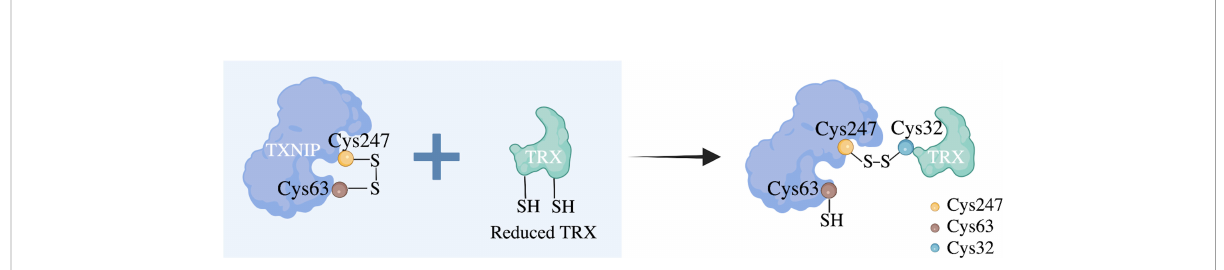
FIGURE 3 Proposed molecular mechanism of the negative regulation of TRX by TXNIP. The cellular redox state-dependent disul fi de bond switching mechanism regulates the inhibition of thioredoxin (TRX) by thioredoxin-interacting protein (TXNIP). TXNIP contains an intramolecular disul fi de band between cysteine residue (Cys) 63 and Cys247 that can interact effectively with TRX. Under normoxic conditions, TXNIP forms stable TRX- mixed disul fi de bonds by disul fi de exchange with reduced TRX and binds to TRX through the intermolecular disul fi de bond formed between TXNIP Cys247 and TRX Cys32 to inhibit its reducing activity. Cys residues are indicated as